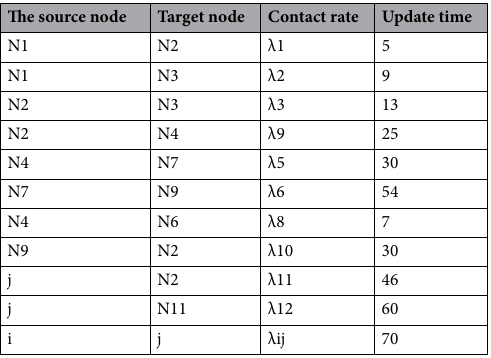
Table 4. The updated contact rate estimation table of node i.